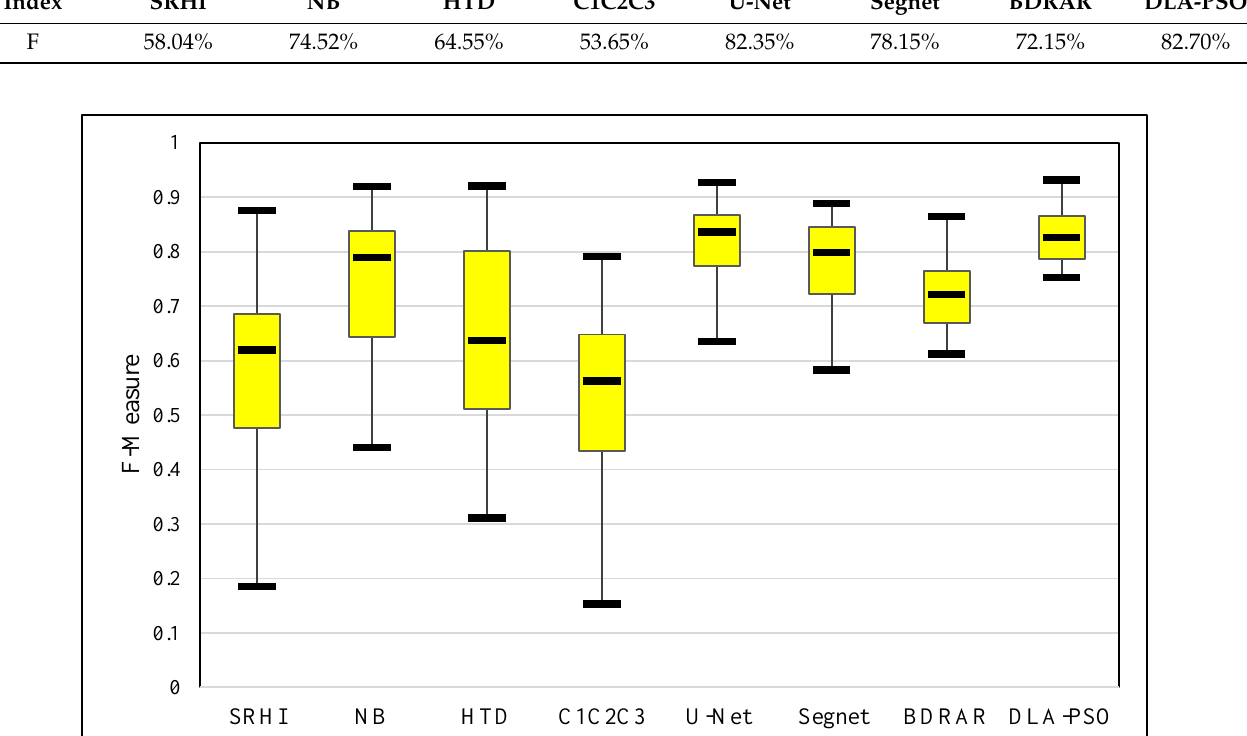
Figure 10. Boxplot of the F-score distributions of different shadow-detection methods. Table 7. Average shadow-detection F values of different shadow-detection methods.